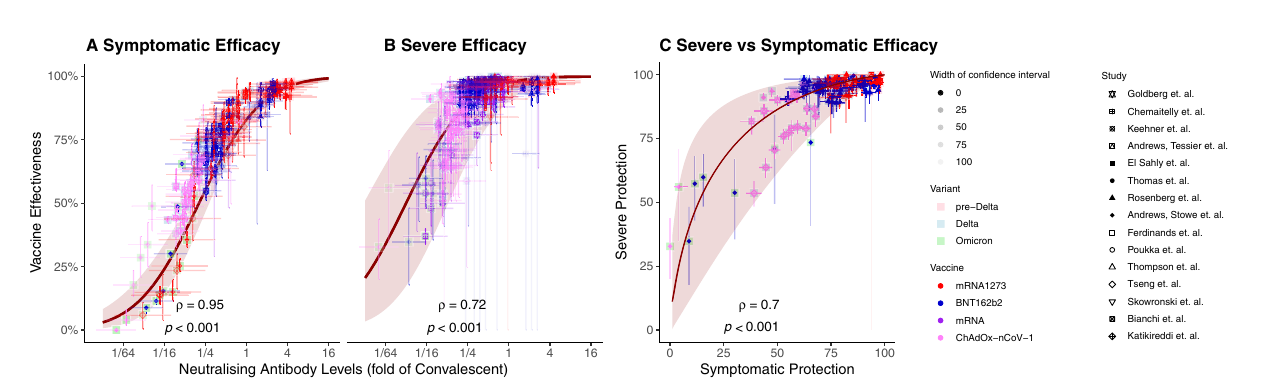
Fig. 2 | Results of linear mixed effects regression model fi t to vaccine effec- tiveness data against severe COVID-19 extracted from our systematic review. VaccineeffectivenessdataagainstsevereCOVID-19(pointsandwhiskersfor95%CI) areshownforpre-Delta(toprow,panels( A ) – ( D ),Delta(middlerow,panels( E ) – ( H )) andOmicron(bottomrow,panels( I ) – ( L ))variants.Notethatforpanels( D )and( I ), no effectiveness data was available. Opacity indicates the degree of con fi dence in